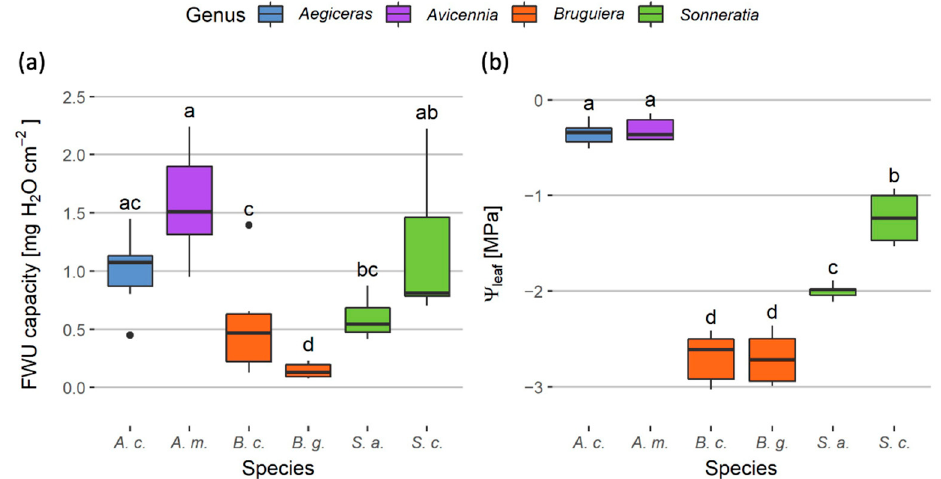
Figure 2. Box plots of the leaf parameters for the six different mangrove species, belonging to four genera, with the following parameters of study: ( a ) foliar water uptake (FWU) capacity and ( b ) leaf water potential ( Ψ leaf ). Box plot midlines are medians, and box edges show first and third quartiles, with whiskers representing minimum and maximum values. Circles indicate outliers in the dataset. Letters at the top of the box plots indicate differences of significance ( p < 0.05) among groups based on Tukey’s comparisons, for which the data of FWU capacity were log-transformed. Abbreviations: A.c. = Aegiceras corniculatum , A.m. = Avicennia marina , B.c. = Bruguiera cylindrica , B.g. = Bruguiera gymnorhiza , S.a. = Sonneratia alba and S.c. = Sonneratia caseolaris .